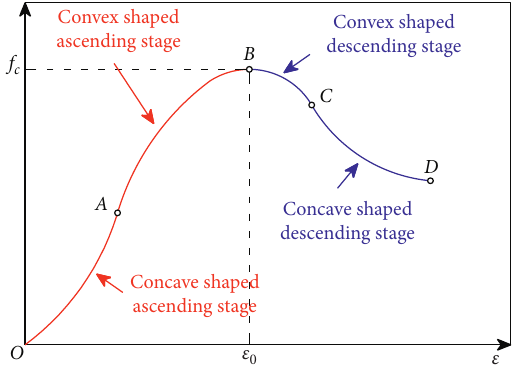
Figure 11: Characteristics of stress-strain